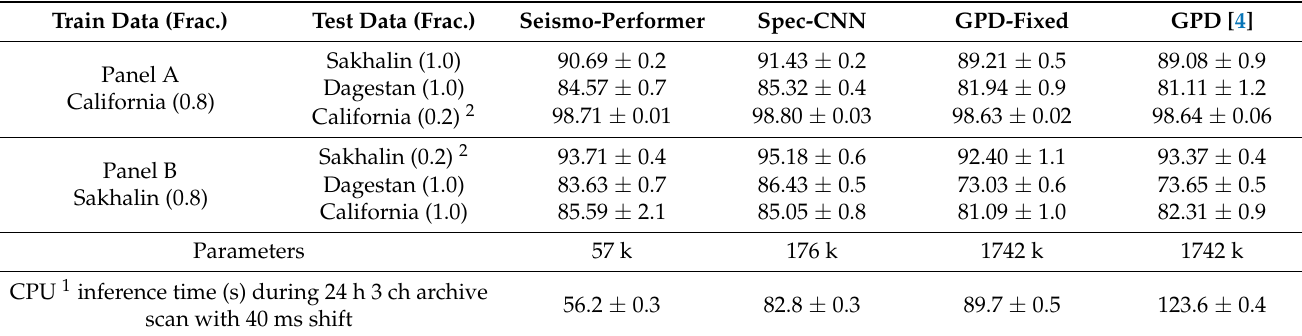
Table 3. Comparison of the TOP-1 accuracy in percent ( ± std.dev.) and inference times on CPU 1 in seconds on test datasets. All models were fitted 10 times on the California (Panel A) and Sakhalin (Panel B) train sets with different random seeds. We reserved 20% of the training dataset for validation at each iteration with different seeds. Train Data (Frac.)